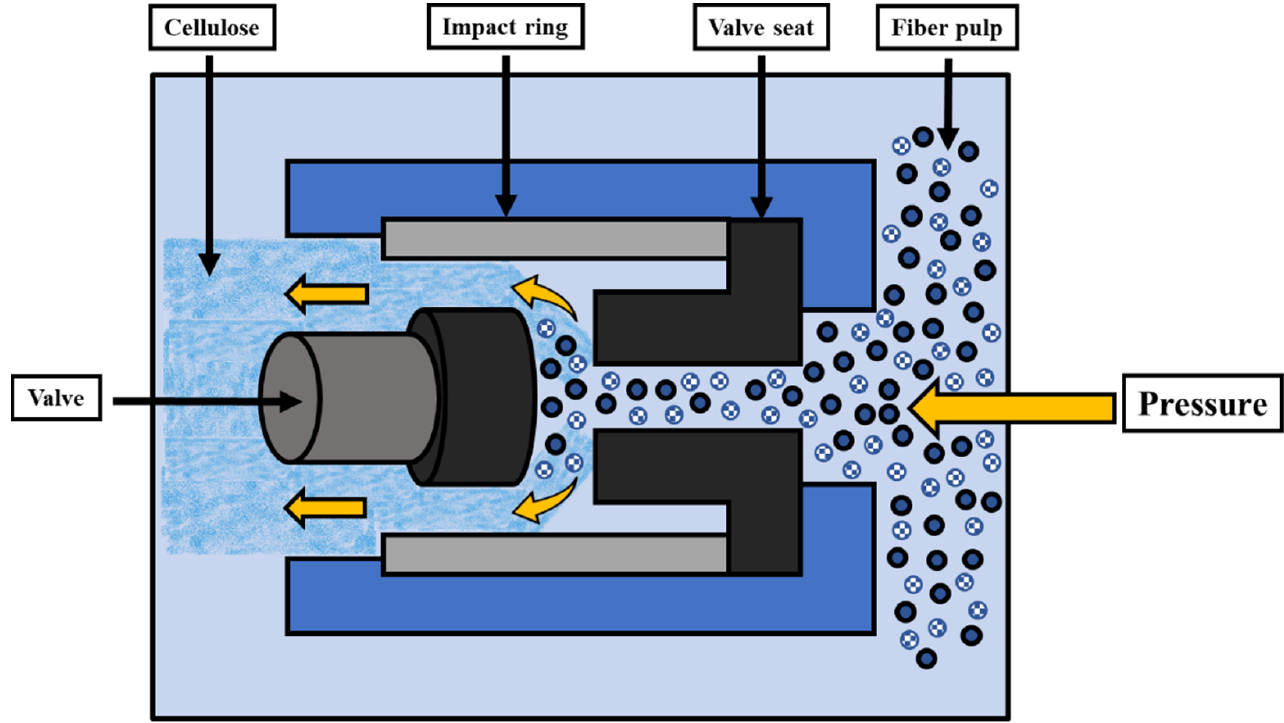
Figure 3. Schematic for HPH.